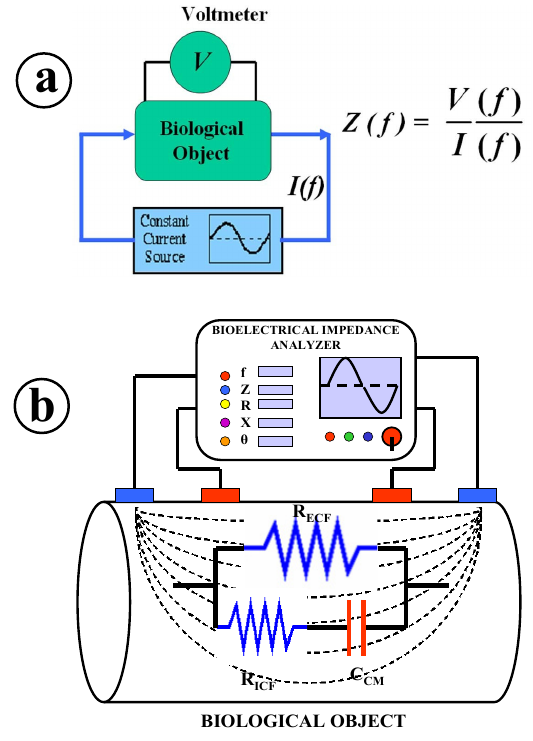
Figure-1: (a) A schematic of electrical impedance measurement, (b) four electrode measurement of electrical transfer